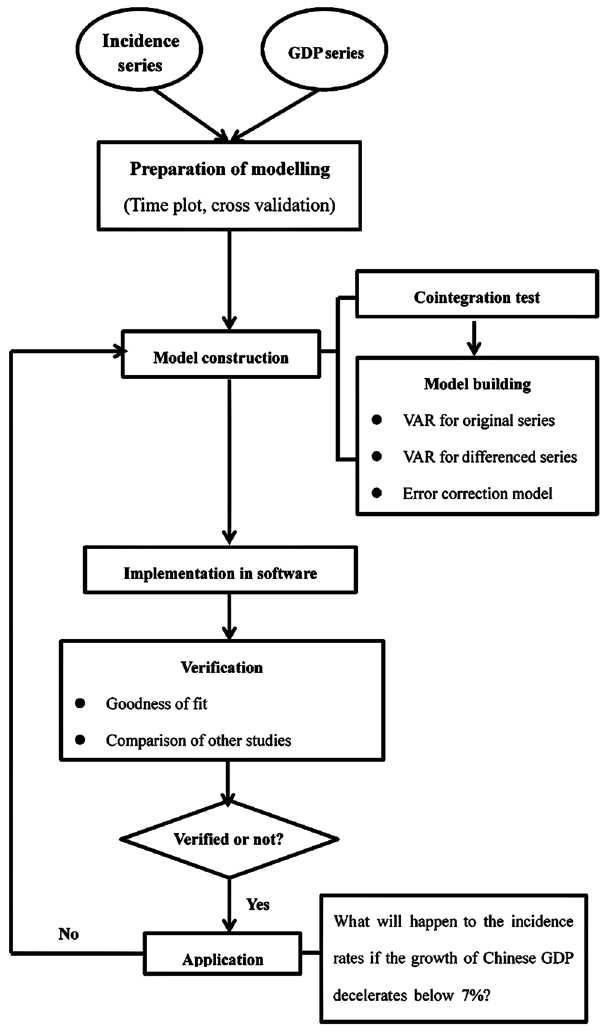
Figure 1. The process of